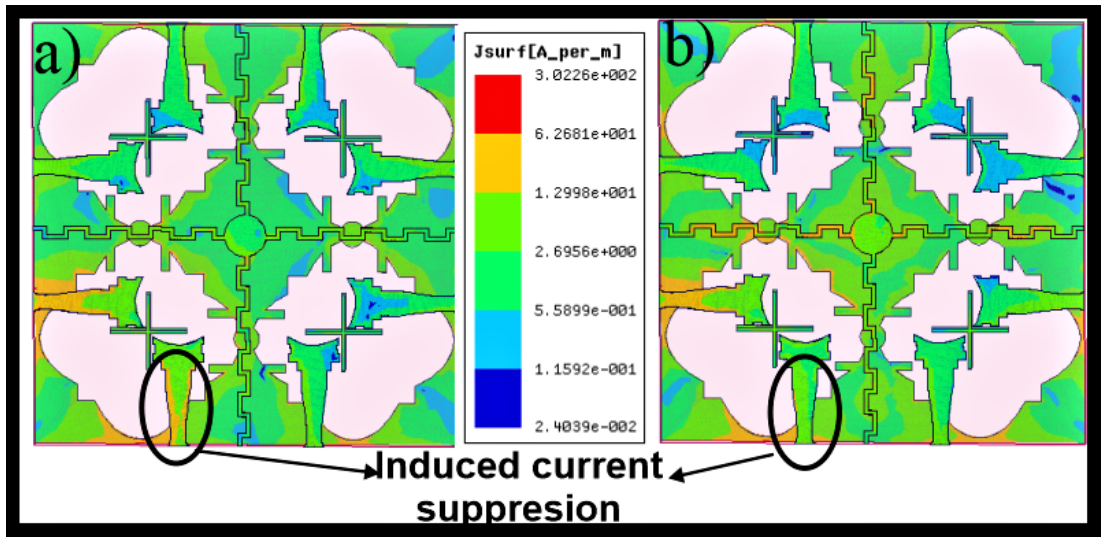
Figure 6. J-surf: ( a ) 3.5 GHz; ( b ) 5 GHz.